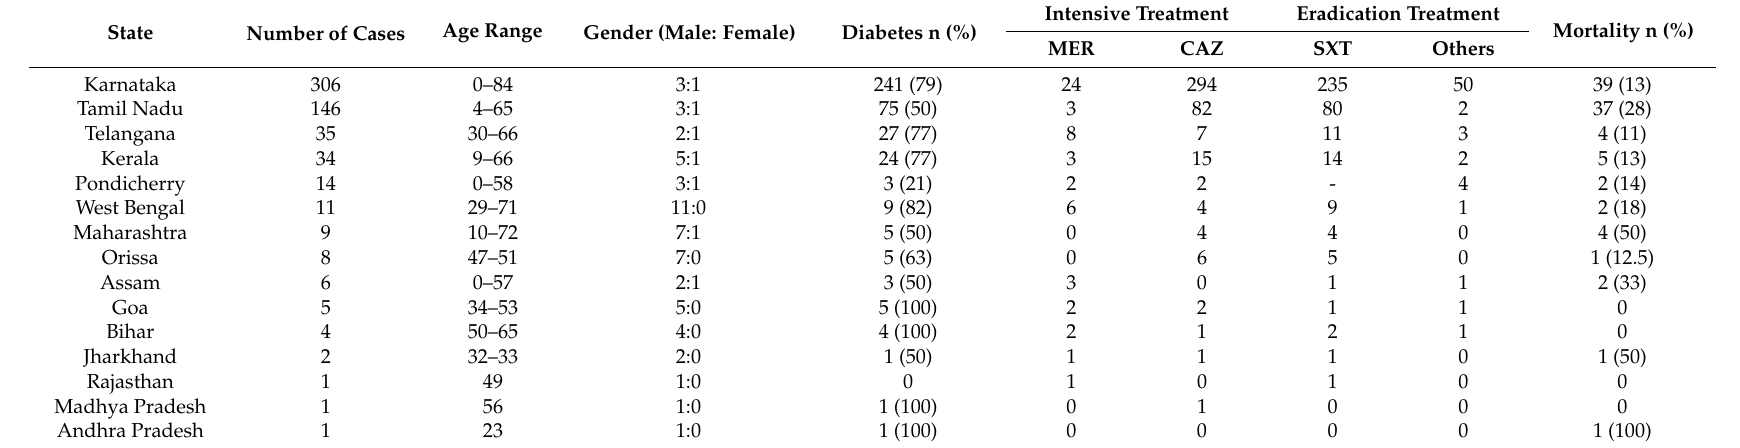
Table 1. Published cases of melioidosis reported from different states of India (1991–2018) (see Supplementary material for reference